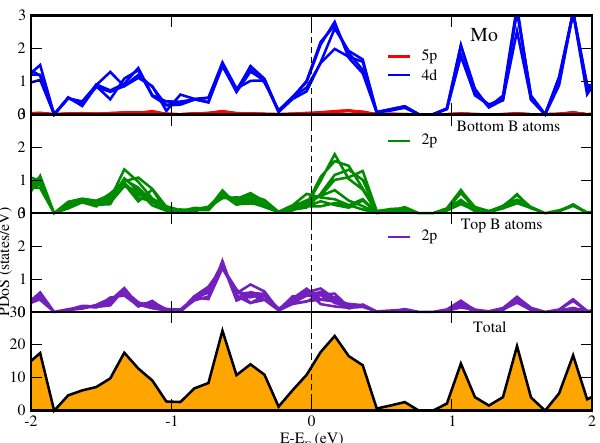
Figure 5. Projected density of states of MoB 2 monolayer on removing the MoS 2 layer from the HS.